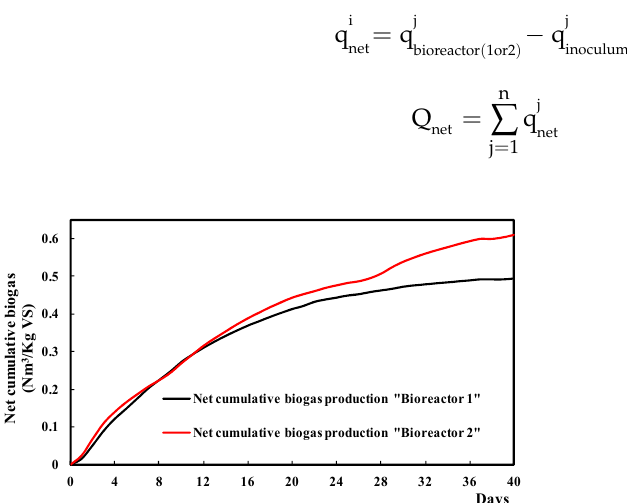
Figure 6. Net cumulative biogas production of the two bottles.